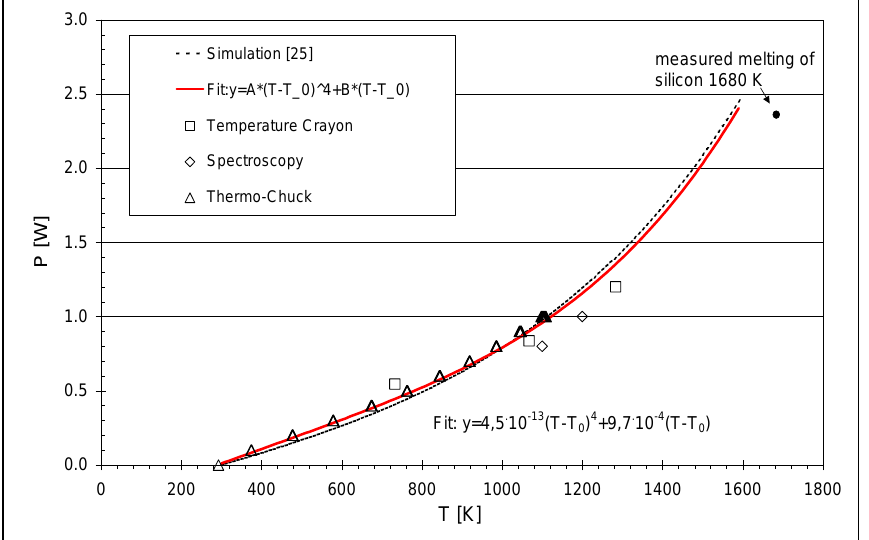
Figure 4. Electrical power consumption as a function of the hotplate temperature for the IR emitter devices shown in Fig. 3. Data points correspond to independent kinds of temperature measurements. The solid (red) and dashed (black) lines stand for a polynomial fit and for the simulation results obtained from a thermal resistor model, described in detail in